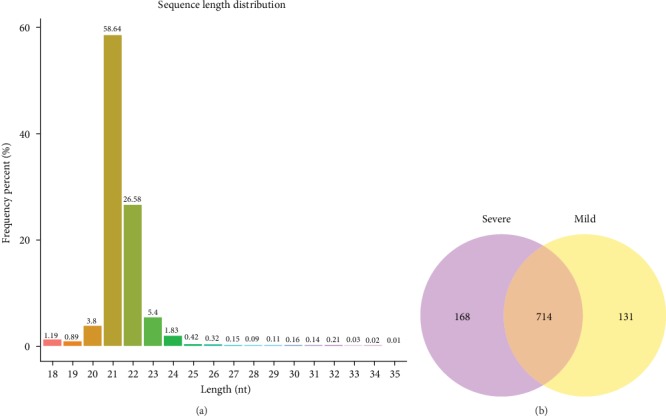
Differential expression of miRNAs in the whole blood from children with mild and severe RSV-associated pneumonia. (a) High-throughput sequencing analyzed the distribution of small RNAs in whole blood samples from children with RSV-associated pneumonia. The miRNA peaks appeared around 20–24 nt. (b) Venn diagram of differentially expressed miRNAs between severe RSV-infected and mild RSV-infected children. Mild: children with mild RSV-associated pneumonia; Severe: children with severe RSV-associated pneumonia.